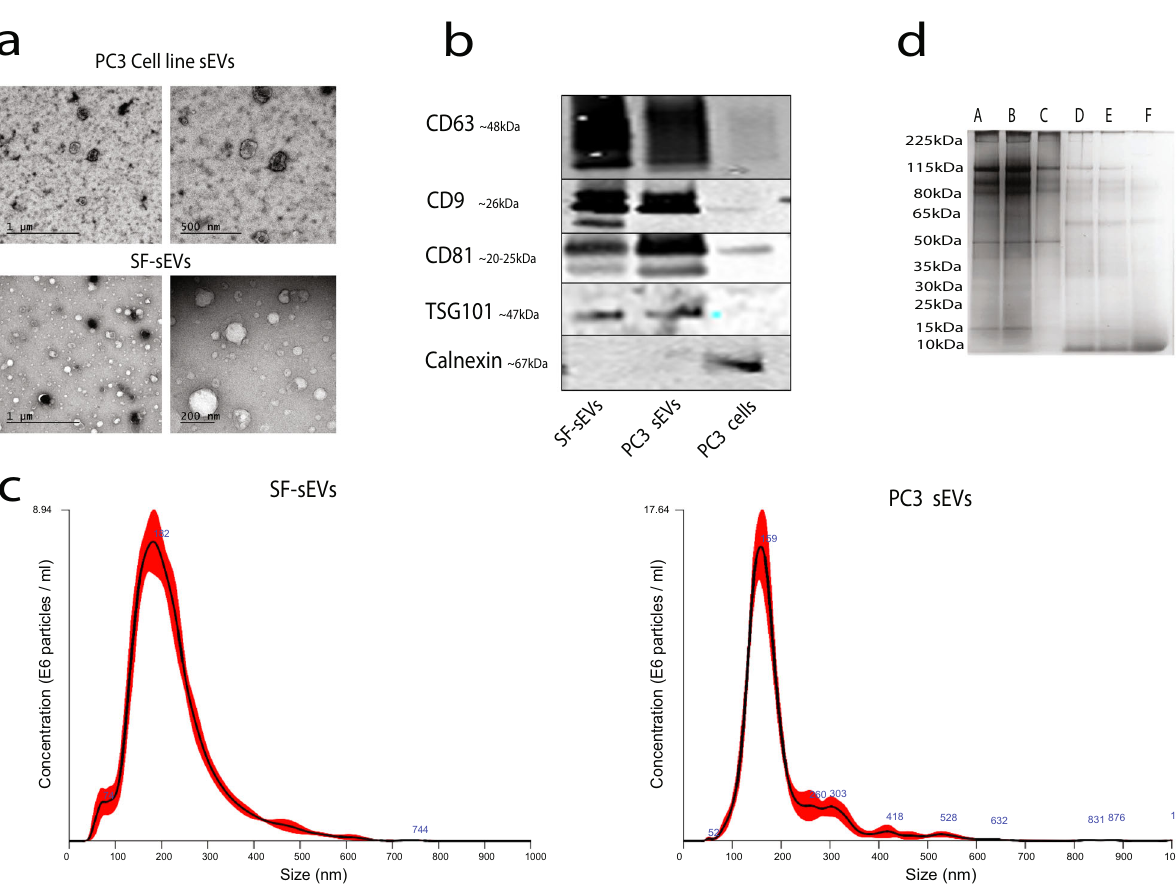
Fig. 2 Quality control of seminal fl uid and PC3 sEVs. a Negative stained-EM of SF-sEVs and PC3 sEVs. b Western blot results for sEV markers TSG-101, CD63, CD81, and CD9. The ER marker calnexin was targeted as a negative control. c NTA analysis of the mode particle diameter recorded values of 155.8 and 192.2 nm for SF-sEVs and PC3 sEVs, respectively. d The quality of the puri fi cation was evaluated by gel electrophoresis for PC3 sEVs and SF-sEVs Repl 2 and Repl 3. A: Total minus surface fraction PC3 sEVs; B: Total minus surface fraction SF-sEVs Repl 2; C: Total minus surface SF-sEVs fraction Repl 3; D: Surface SF-sEVs fraction Repl 2; E: Surface SF-sEVs fraction Repl 3; F: Surface fraction PC3 sEVs.